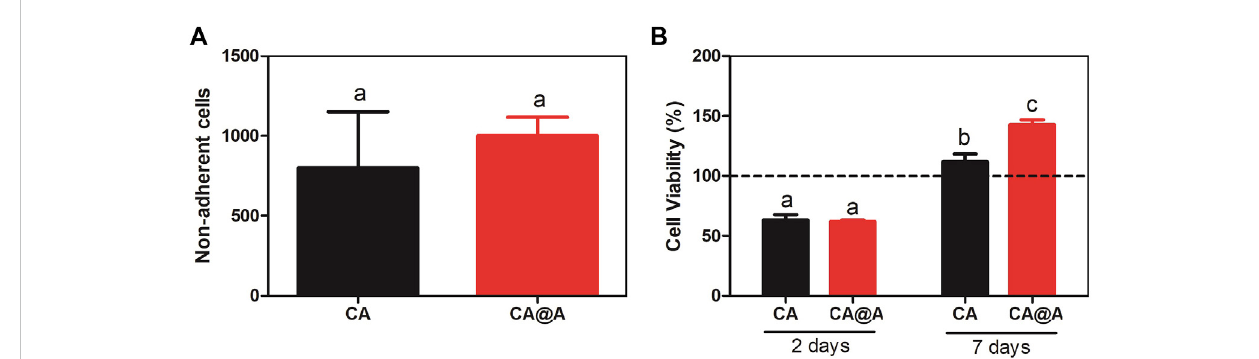
FIGURE 4 Initial analysis of cell-biomaterial adhesion and cell viability index. (A) C2C12 cell attachment to cellulose acetate (CA) and cellulose acetate nano fi bers with annatto extract (CA@A)determined by cell supernatant counting after 24 h. (B) Graph representing % cell viability through the MTT assay of C2C12 myoblast cells incubated onto cellulose acetate (CA) and cellulose acetate nano fi bers with annatto extract (CA@A) over 2 days and 7 days. The dotted line represents control, C2C12 plated on a monolayer for 2 and 7 days. Different letters demonstrate signi fi cant differences determined by a Student ’ s test ( p <